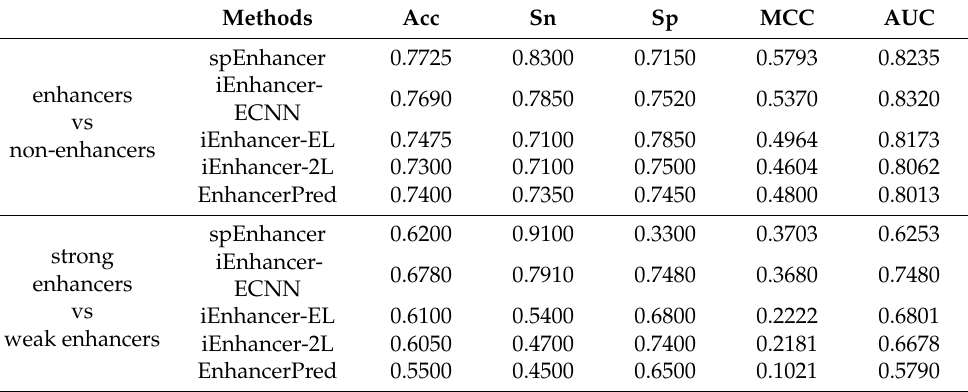
Table 5. Comparison of results between spEnhancer and the three existing methods on the indepen- dent test